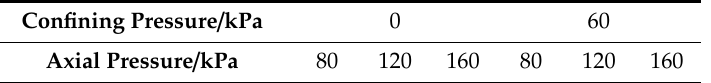
Table 3. Loading scheme of triaxial creep test for asphalt mixture.